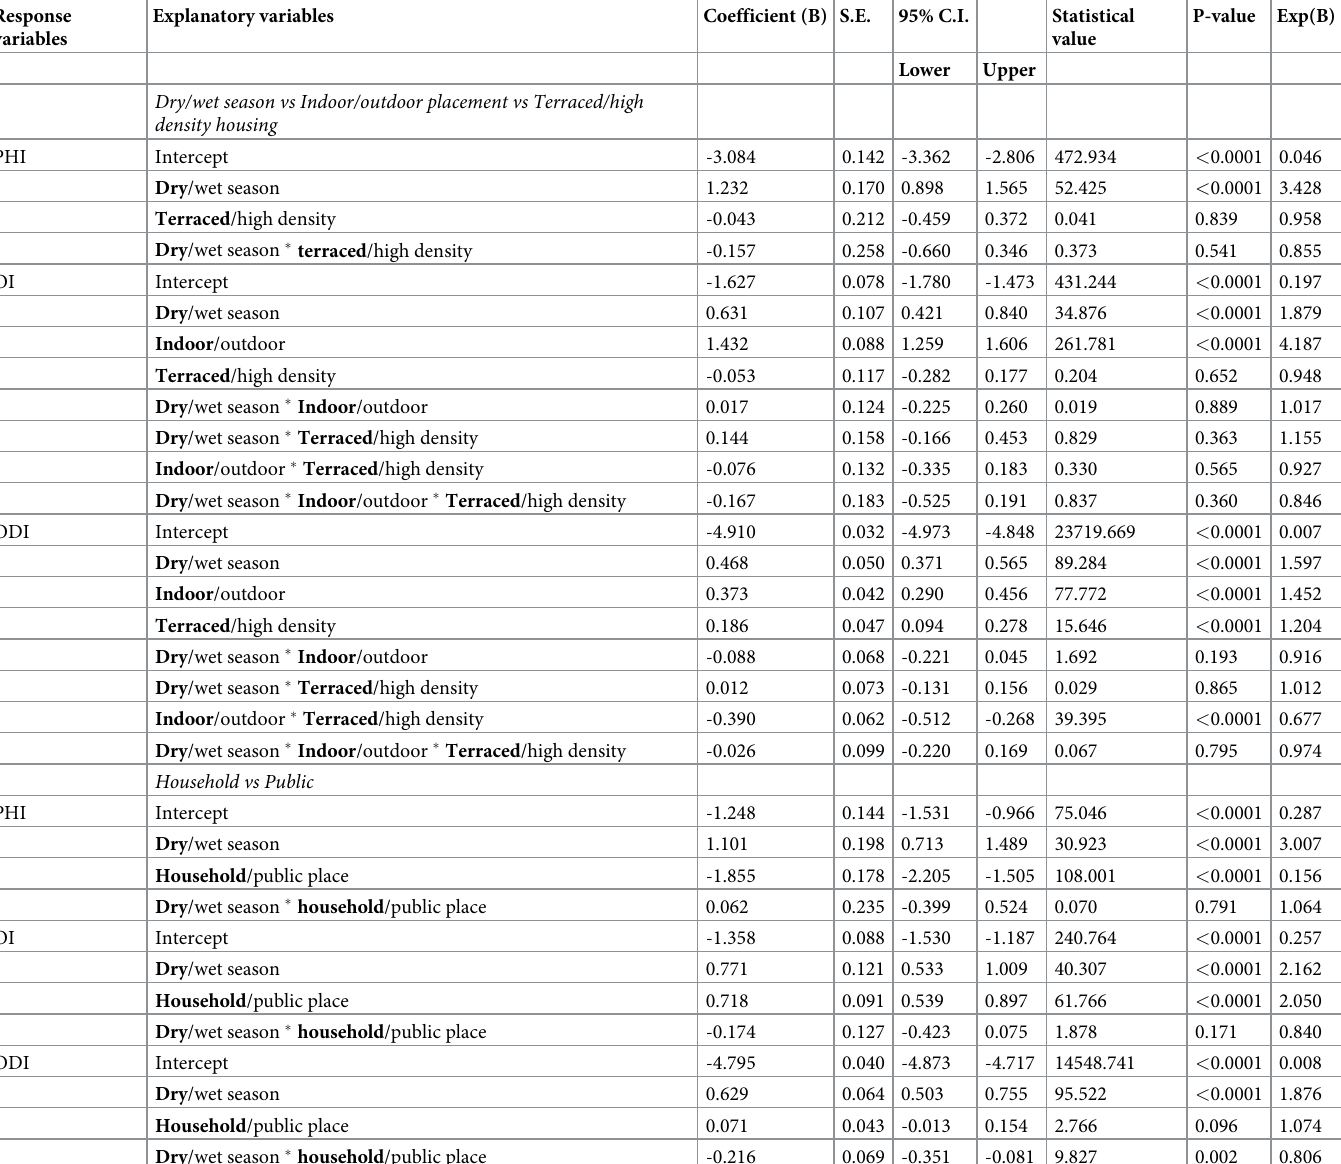
Table 2. Results of generalized linear model analysis of effects of seasonality, ovitrap placement location, and housing type on vector indices. PHI and OI were sub- jected to binary logistic regression, whereas ODI was subjected to negative binomial regression. Explanatory variables in bold were considered as the reference. Response Explanatory variables